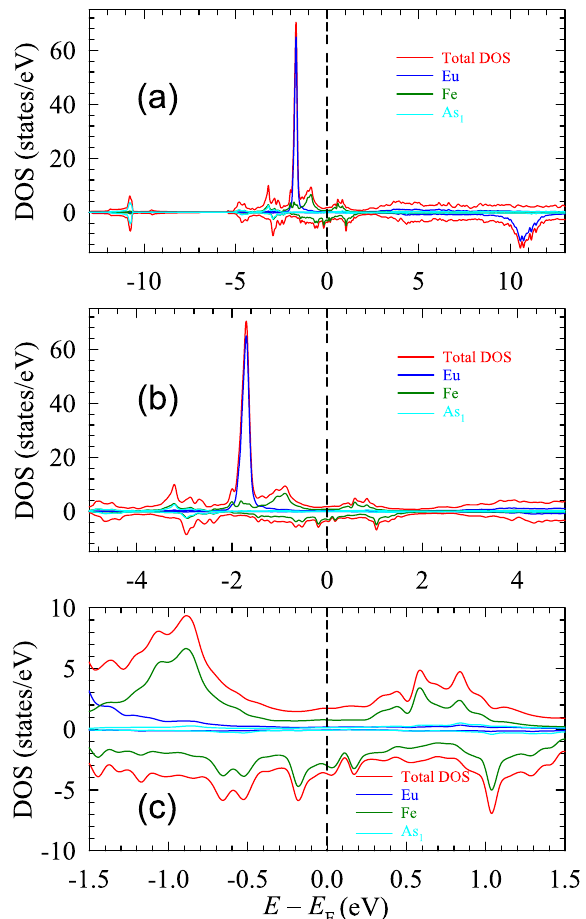
Figure 3. Spin-resolved, total and atom-resolved DOS in EuFeAs 2 for the energy range between − 13 and 13 eV ( a ), − 5 and 5 eV ( b ), and − 1.4 and 1.4 eV ( c ). SigmaPlot v14, www. systa tsoft ware.